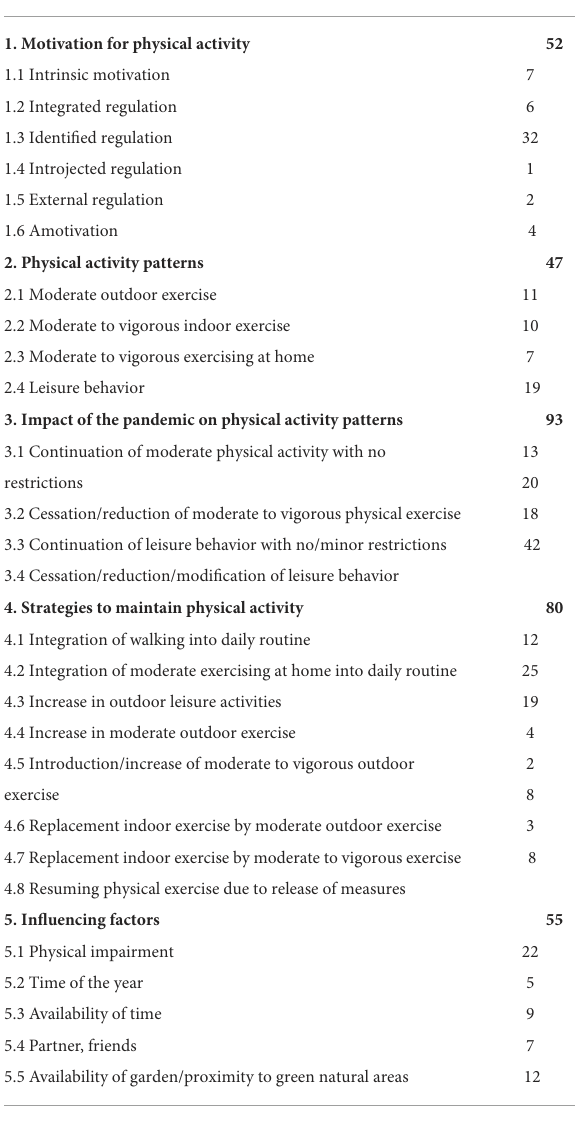
patterns during the pandemic. Main codes and